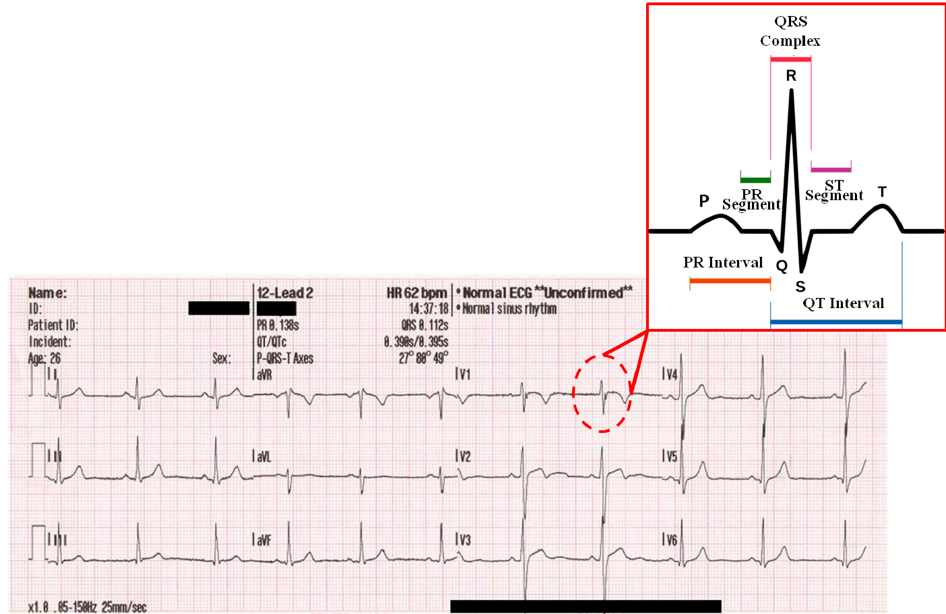
Figure 1. Electrocardiogram of a 26-year-old male (scale of the order of seconds). The electrical signal varies abruptly in a short period of time as detailed in the box (of the order of ms). A multiscale scheme considering both the fine temporal scale (ms) and the coarse one (s) is necessary to analyze the evolution of a cardiac disease, as an example, for long periods of time. Pictures taken from